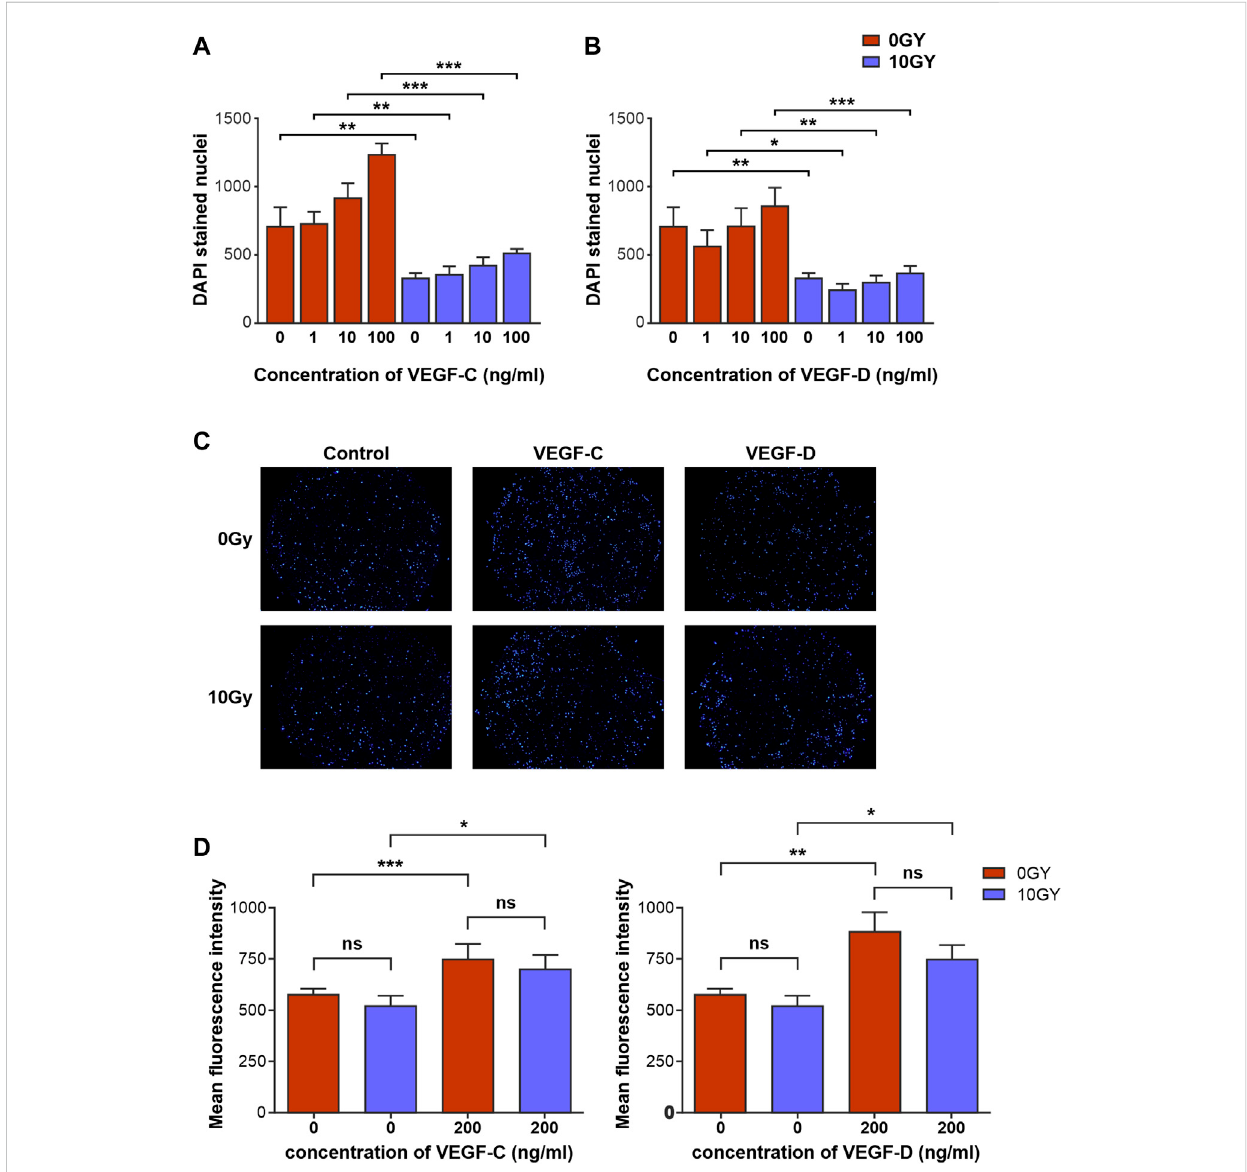
Radiotherapy differentially alters responsiveness of LEC to classical lymphangiogenic growth factors in vitro . Quanti fi cation of the effects of various concentrations of (A) VEGF-C and (B) VEGF-D on proliferation of 0 Gy and 10 Gy LEC. (C) Panel of DAPI stained 0 Gy and 10 Gy LEC representing transmigratedcellsinresponsetocontrol,VEGF-CandVEGF-Dchemotacticgradients. (D) Quanti fi cationof0 Gyand10 GyLECchemotaxisinresponse to VEGF-C and VEGF-D. All assays performed aminimum of n = 3times (with atleast3technicalreplicates per assay). Data expressedas mean,with error bars representing SEM. p values calculated using one-way Anova. * p < 0.05; ** p < 0.01; *** p <